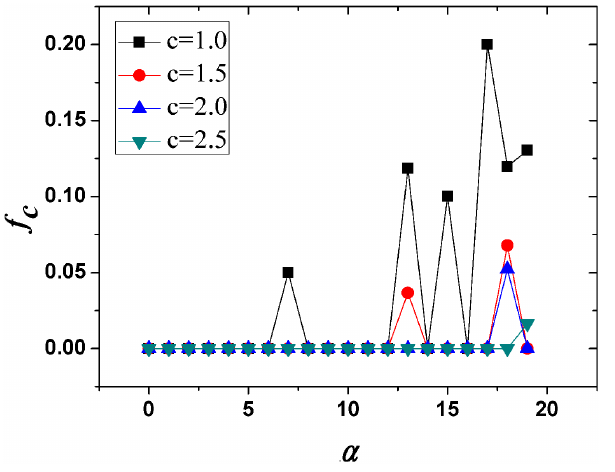
Figure 7. An identical simulation test is performed on a scale free BA network. The network has exactly the same number of nodes and edges as that in Facebook dataset 1. We observe no significant influence of a on the evolution of